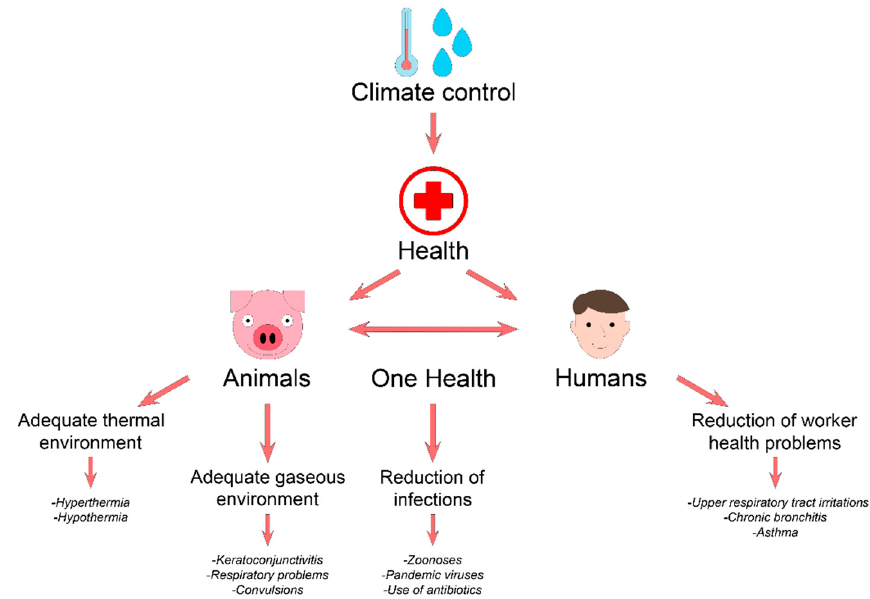
Figure 3. Relation between climate control and health of both humans and